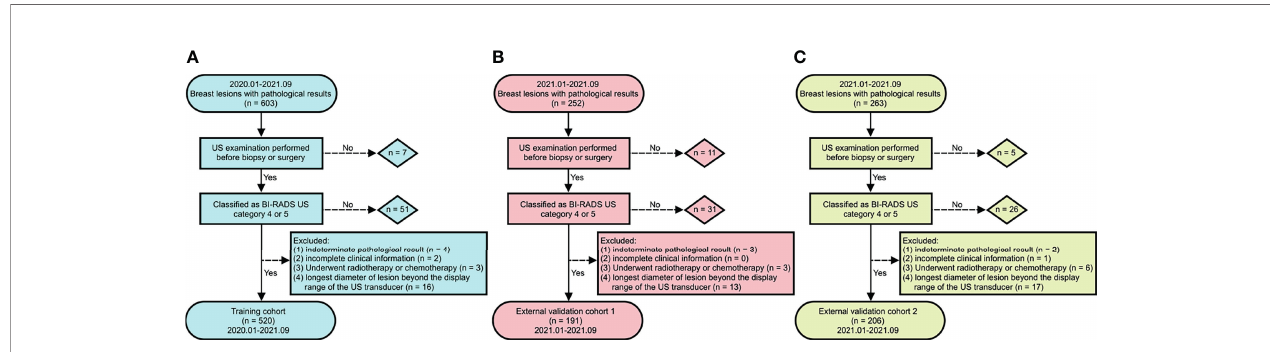
TABLE 1 | Comparisons of patient demographics and baseline characteristics in the training and validation cohorts.